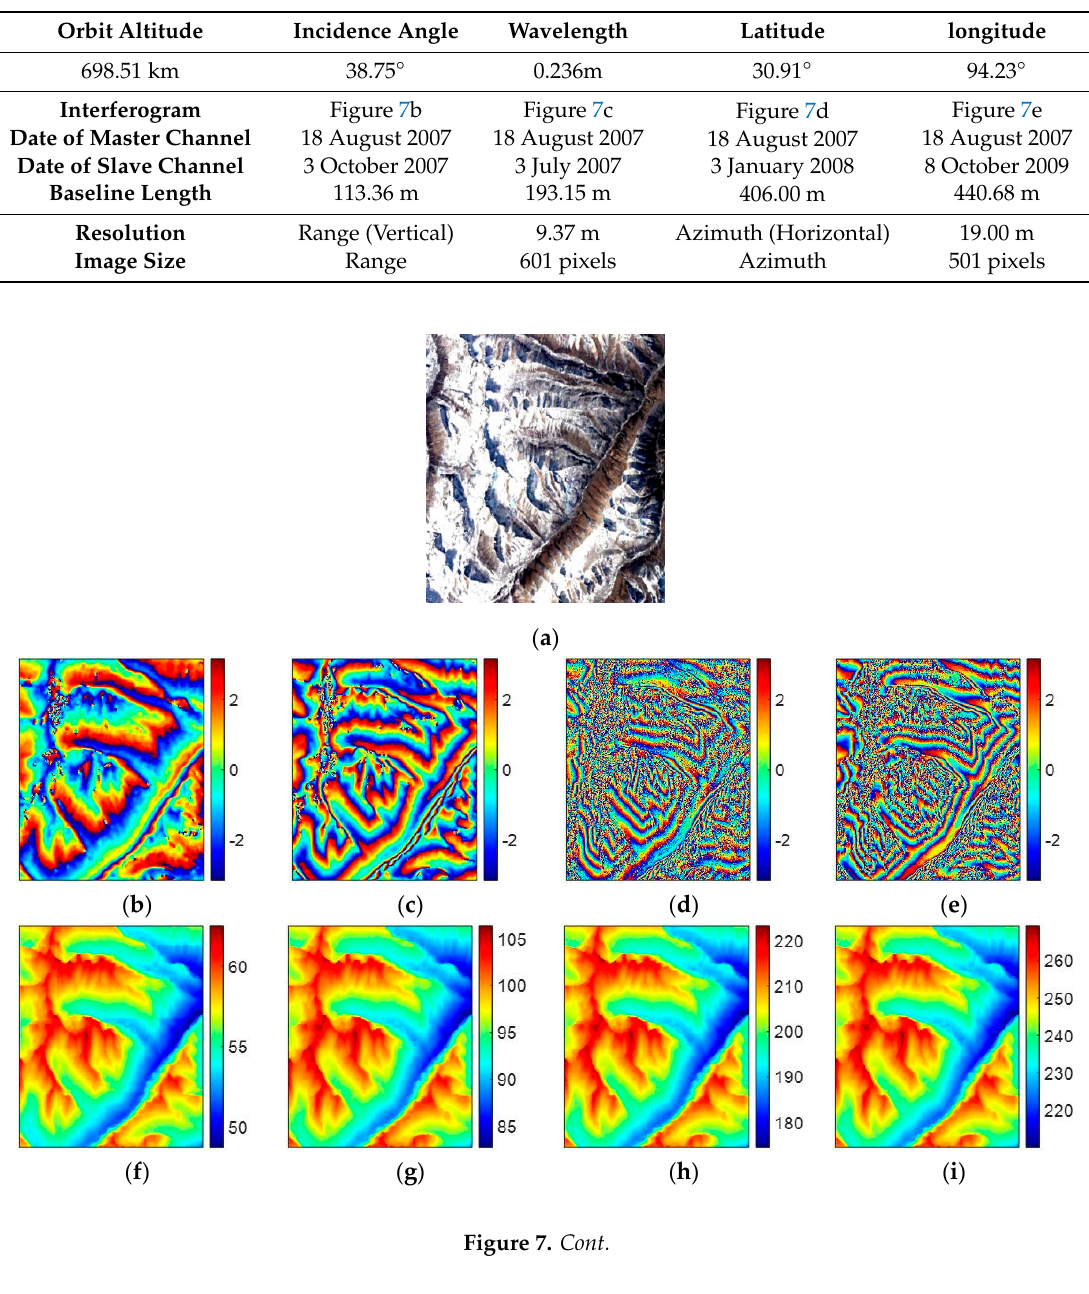
Table 6. Major interferometric parameters of real MB dataset of ALOS PALSAR.